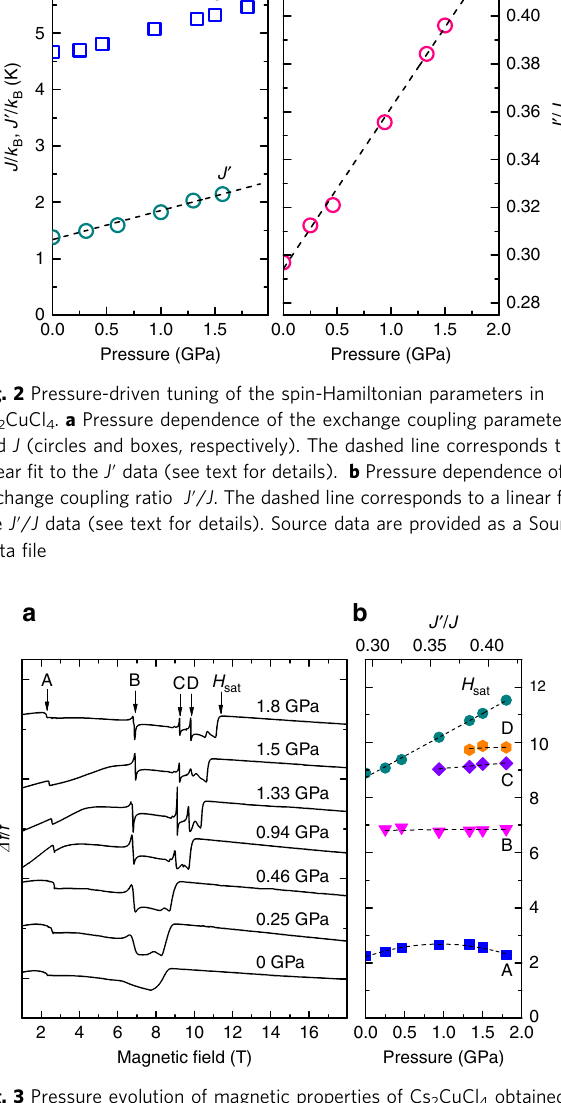
Fig. 3 Pressure evolution of magnetic properties of Cs 2 CuCl 4 obtained by means of TDO technique ( T = 350 mK, H || b ). a Pressure dependence of the TDO frequency changes Δ f / f in response to the magnetic fi eld (the data are offset for clarity). b Dependencies of TDO frequency anomalies on the applied pressure. The calculated exchange coupling ratio J ′ / J is shown on the top scale (see text for details). Lines are guides for the eye. Source data are provided as a Source Data fi le spin-polarized phase with saturated magnetization 21 . The experi- ment revealed that with increasing pressure the saturation fi eld moves toward higher magnetic fi elds. The dependence of H sat on the applied pressure is shown in Fig. 3b. we obtained J ′ / k B = 1.38 K and J / k B = 4.66 K ( J ′ / J ≃ 0.3), which perfectly agrees with the previous estimates 6 . Results of a linear fi t to the J ′ dependence (dashed line in Fig. 2a) were used to calculate J at different pressures. J ′ , J , and J ′ / J as functions of the applied pressure are shown in Fig. 2. The J ′ / J dependence can be described using the empirical equation J ′ / J = 0.294(2) + 0.067(2) ⋅ P (dashed line in Fig. 2b), where P is the applied pressure (GPa). NATURE COMMUNICATIONS| (2019) 10:1064